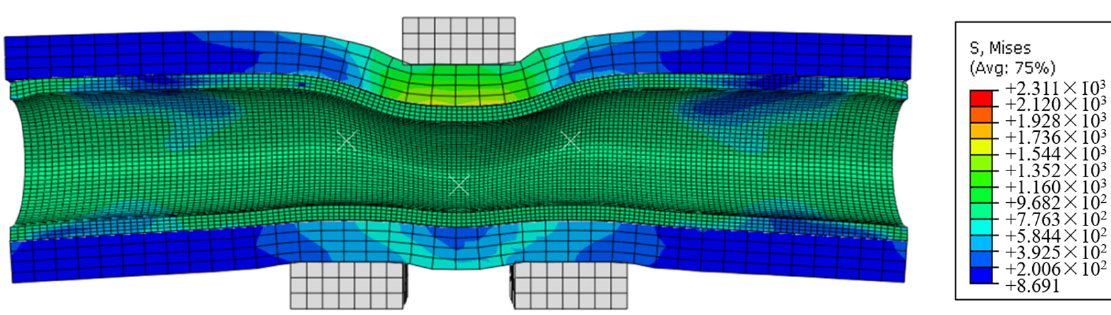
Figure 7. Equivalent stress distribution cloud of cement-sheath casing after shearing.